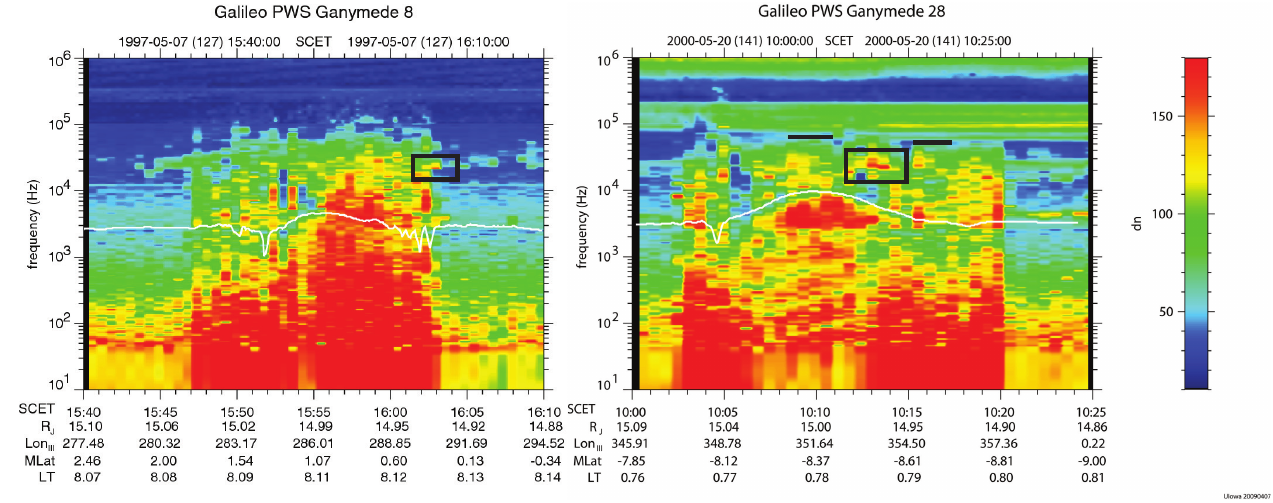
Fig. 10. The PWS spectrograms for G8 (left) and G28 (right) flybys. The black boxes in both panels indicate narrow band radio emissions, and the black lines in the right panel show the nKOM